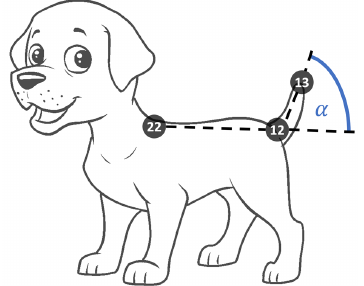
Figure 4. Calculation of the tail position.